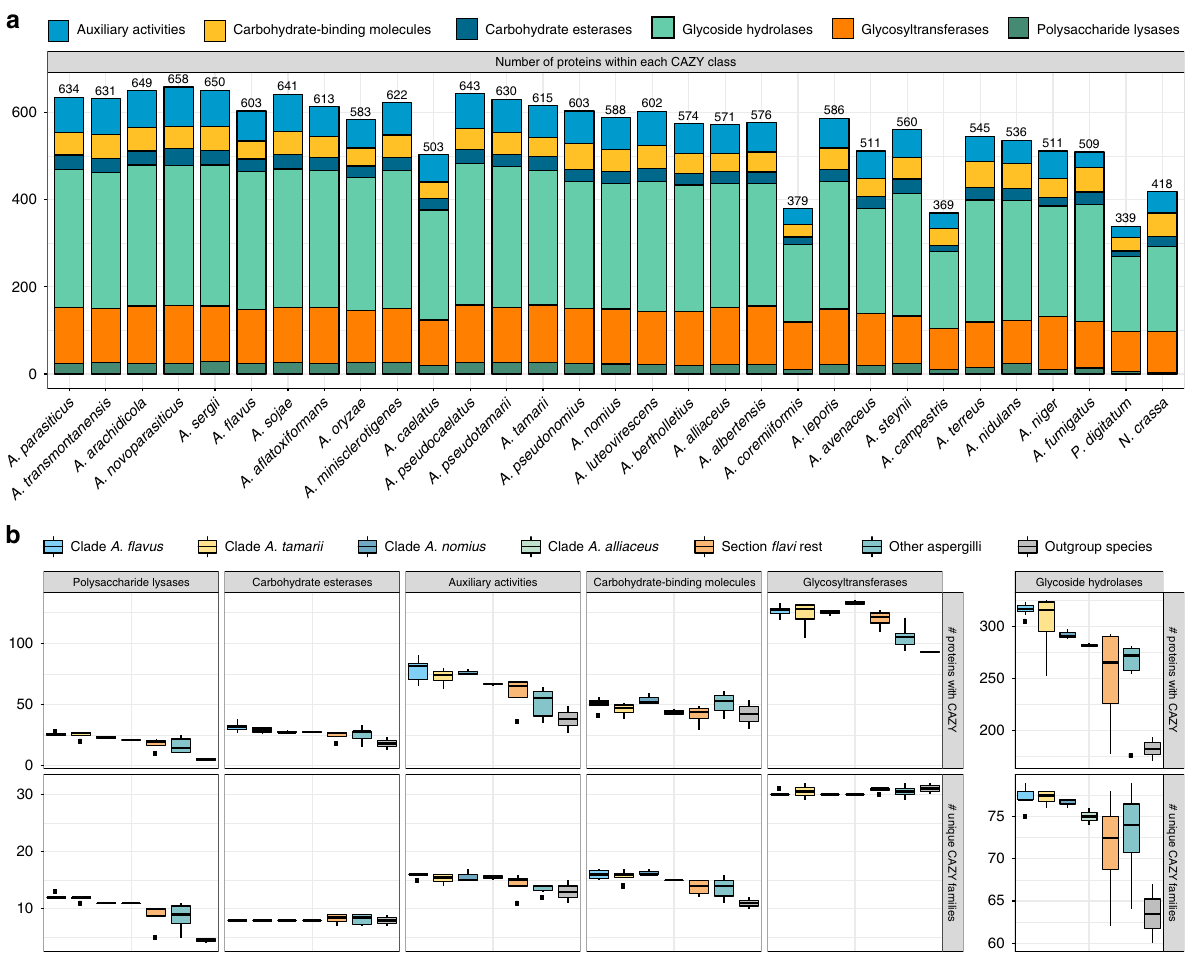
Fig. 4 Carbohydrate-active enzymes (CAZymes) in section Flavi . a The total number of CAZymes in each species distributed on six categories of enzyme activity: auxiliary activities, carbohydrate-binding molecules, carbohydrate esterases, glycoside hydrolases, glycosyltransferases, and polysaccharide lyases. b Boxplot representing the diversity of CAZyme family content and abundance among clade A. fl avus (light blue), A. tamarii (yellow), A. nomius (dark blue), A. alliaceus (light turquoise), the rest of the Flavi section (orange), other Aspergilli (dark turquoise), and non-Aspergillus species (gray). For each CAZyme class the total number of CAZymes (top row) and the number of unique CAZyme families (bottom row) are displayed. In the boxplot the midline represents the median, the upper and lower limit of the box represents the third and fi rst quartile, and the whiskers extend up to 1.5 times the